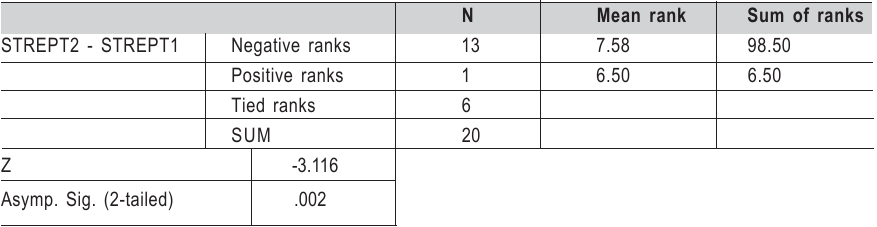
Table 1. Statistical analysis of MS levels before and after use of CHX mouthwash.